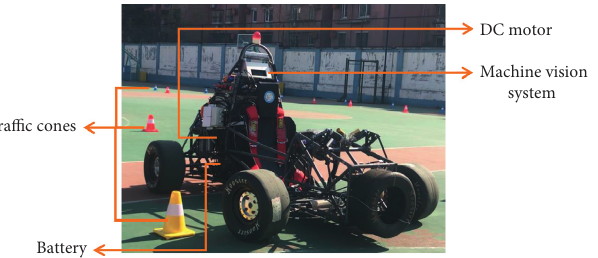
Figure 1: Experiment